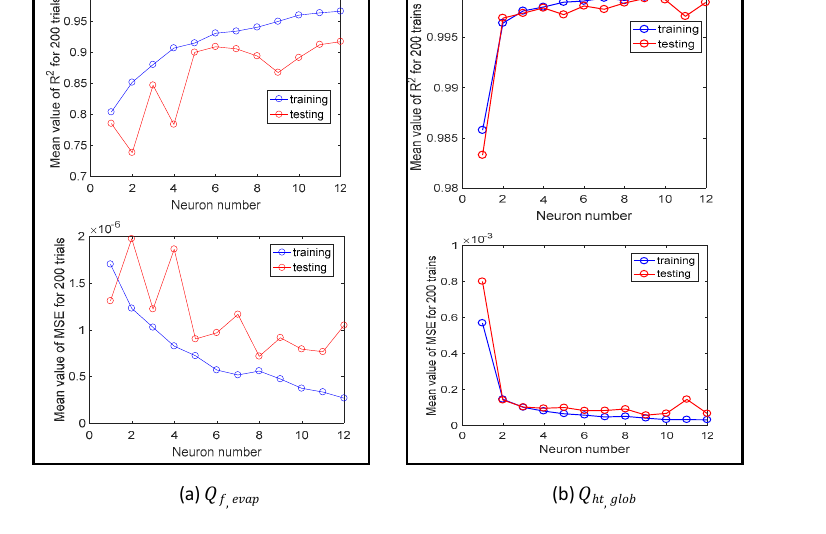
Figure A3. ( a – e ) Mean value of R 2 and MSE over 200 training trials for the ANNs that simulate the different parameters of the physics-based model (heat release simulation), as a function of the number of neurons.